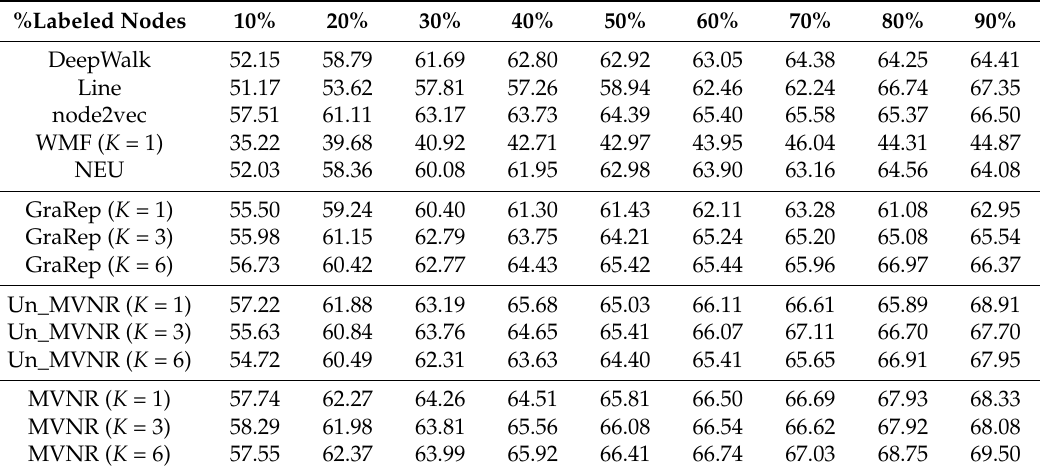
Table 5. Accuracy (%) of vertex classification on